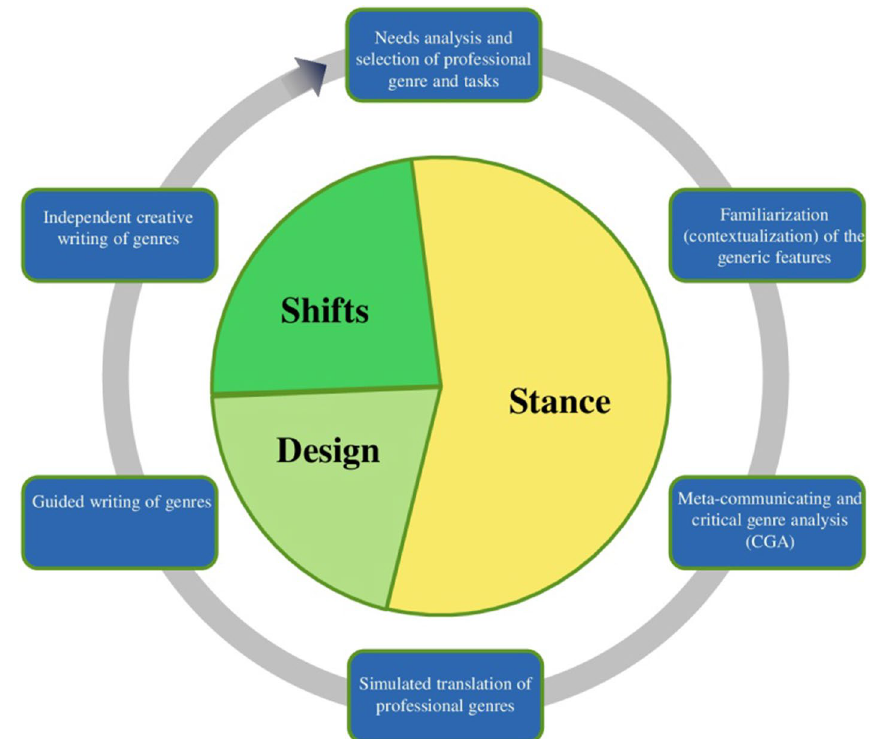
Fig. 1 The Translanguaging-informed Six-stage Genre-based Pedagogical